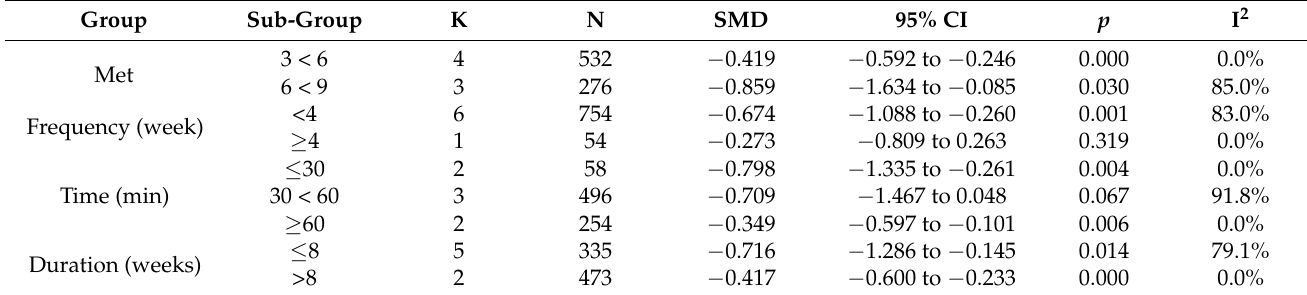
Table 7. Subgroup analysis of physical activity on college students’